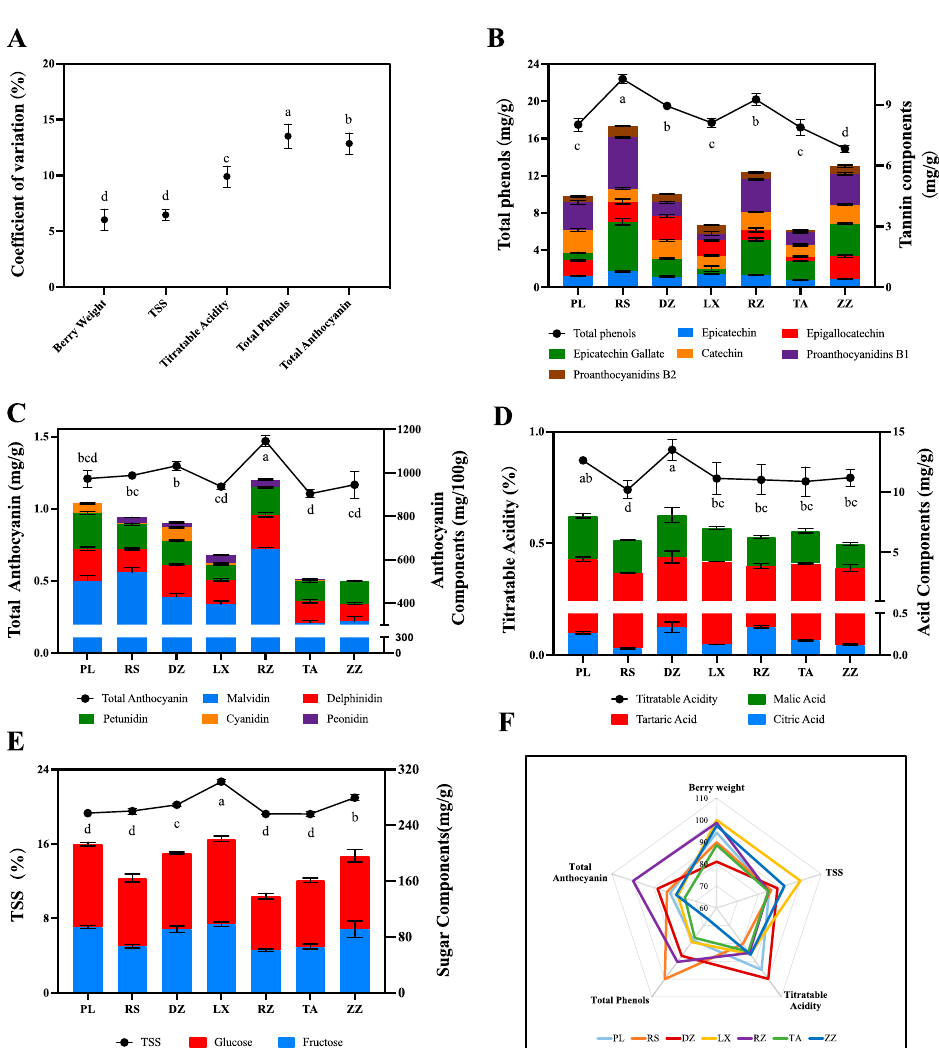
Figure 1. Quality characterization of ‘Cabernet Sauvignon’ berries in seven regions including DZ, LX, PL, RZ, RS, TA, and ZZ at maturity. ( A ) Measurement of Coefficient of Variation (C.V) related to berry weight, TSS, titratable acidity, total phenols, and total anthocyanins of ‘Cabernet Sauvignon’ at maturity level. ( B – E ) Analysis of main components related to total phenolics, total anthocyanins, titratable acid, and TSS, respectively. The broken line represents the quality traits in different regions. The bar represents the charge ratio in different regions from half-véraison to maturity. The different letters indicate the significant differences between regions ( p ≤ 0.05) using Duncan’s test. Experiments were performed using three replicates. mg/g refers to fresh weight. ( F ) Evaluation of seven regions using radar map according to quality characterization.